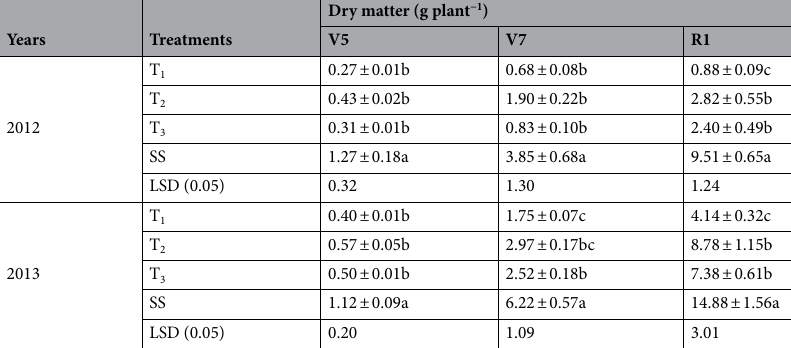
system were obtained in treatments T 2 and T 3 , respectively. Overall, the total grain yield of maize/soybean relay intercropping system showed the trend T 2 > T 1 > T 3 , suggesting that grain yields of both intercrop species were maximized when both crops complement each other with an optimum inter-row spacing (i. e., T 2 ) between soybean and maize rows in MSR (Table 5).